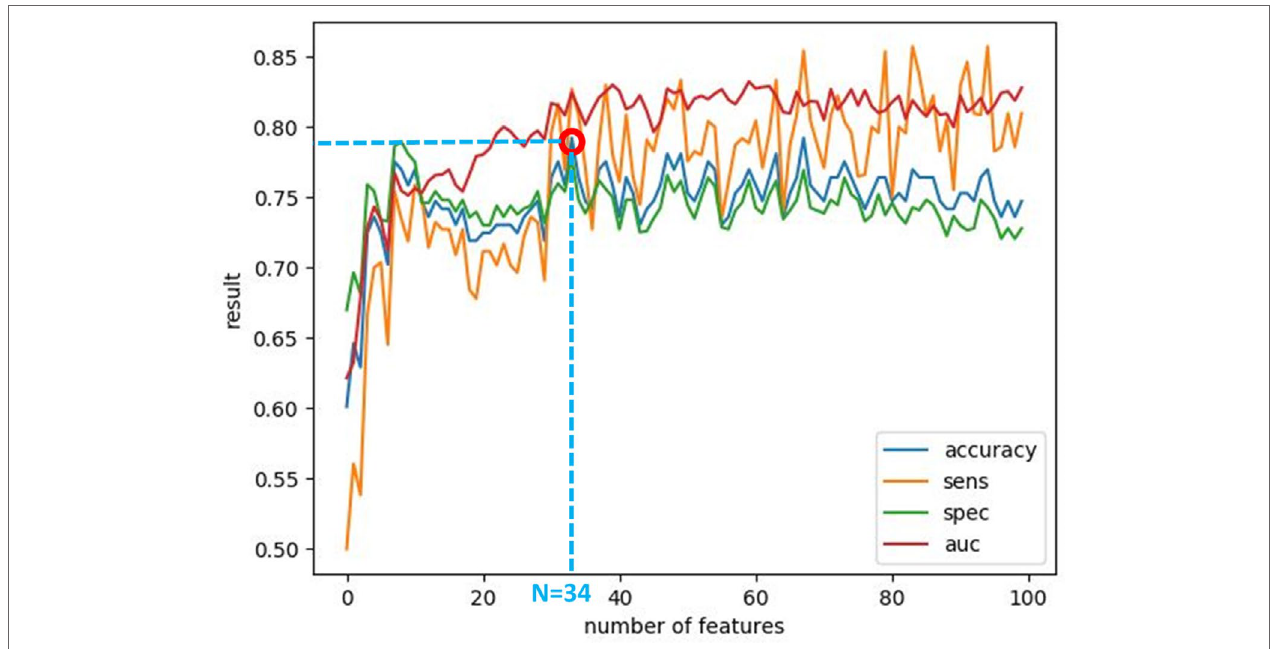
FIGURE 11 | The accuracy, sensitivity, specificity, and AUC obtained by changing the number of selected features for sMRI between 1 and 100 features. The maximum accuracy achieved is obtained when using 34